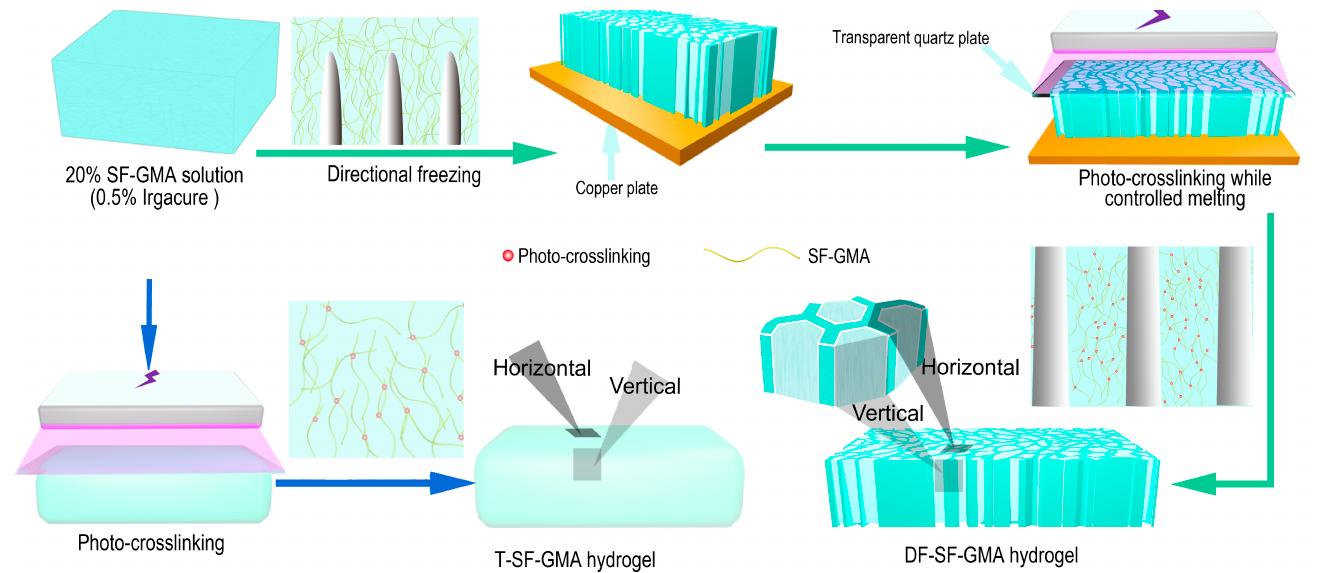
Figure 1. The schematic diagram for the fabrication of the glycidyl methacrylate (GMA) modified silk fibroin (SF) hydrogels with aligned porous structures via directional freezing (DF) and photo- crosslinking (DF-SF-GMA hydrogel) and the traditional SF hydrogel (T-SF-GMA hydrogel). The aligned porous structure of the DF-SF-GMA hydrogels is templated from ice crystal formation due to DF and is maintained after photo-crosslinking during controlled melting.